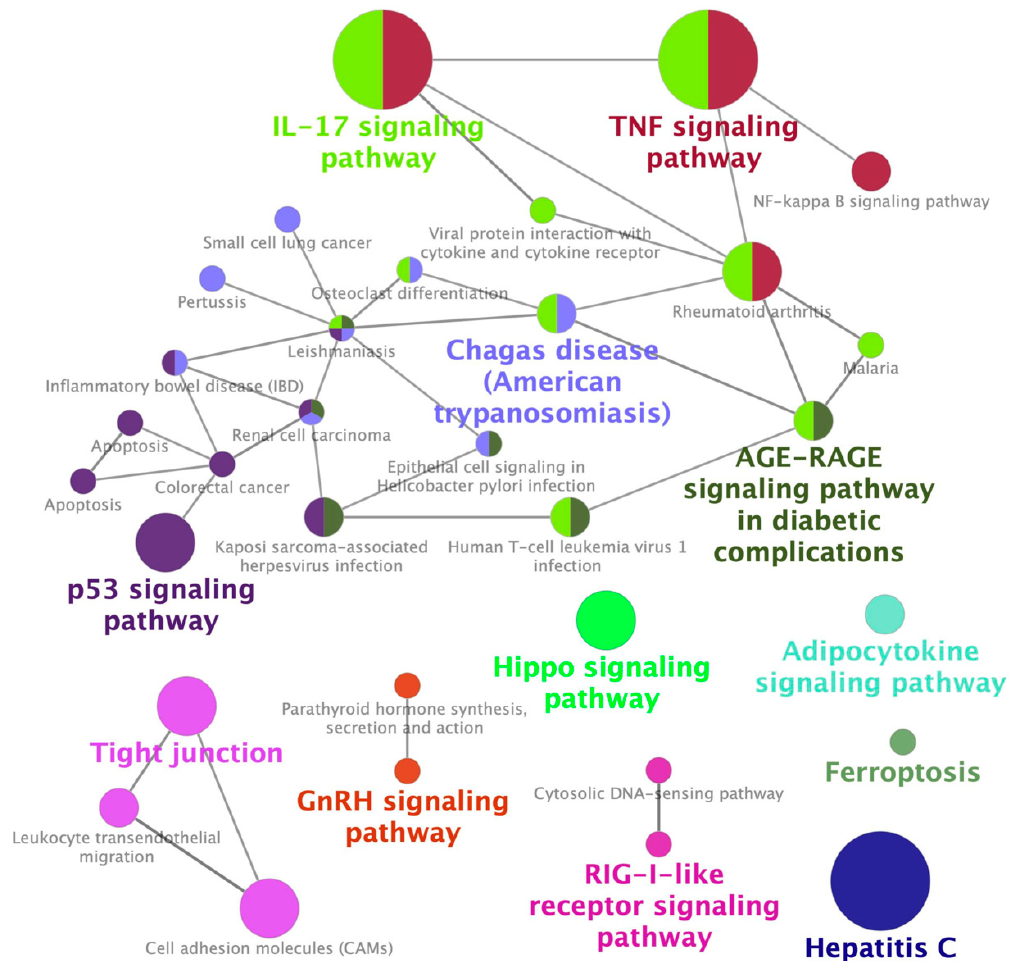
Figure 2. Enrichment of CIN-associated differentially expressed genes in Kyoto Encyclopedia of Genes and Genomes (KEGG) pathways. The 208 genes in the GES-CIN (Table S2) were analyzed with ClueGO using KEGG as the reference database to identify significantly enriched functional networks.